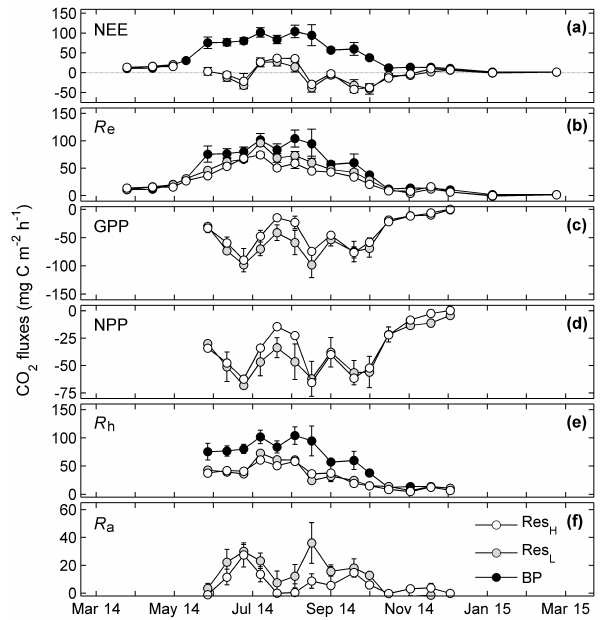
Figure 2. (a) Net ecosystem CO 2 exchange (NEE), (b) ecosys- tem respiration ( R e ), (c) gross primary production (GPP), (d) net primary production (NPP), (e) autotrophic respiration ( R a ) and (f) heterotrophic respiration ( R h ) in restoration treatments with high (Res H ) and low (Res L ) water table level and bare peat (BP); error bars indicate standard error; the horizontal dotted line in (a) visual- izes the zero line above and below which CO 2 emission and uptake occur, respectively.